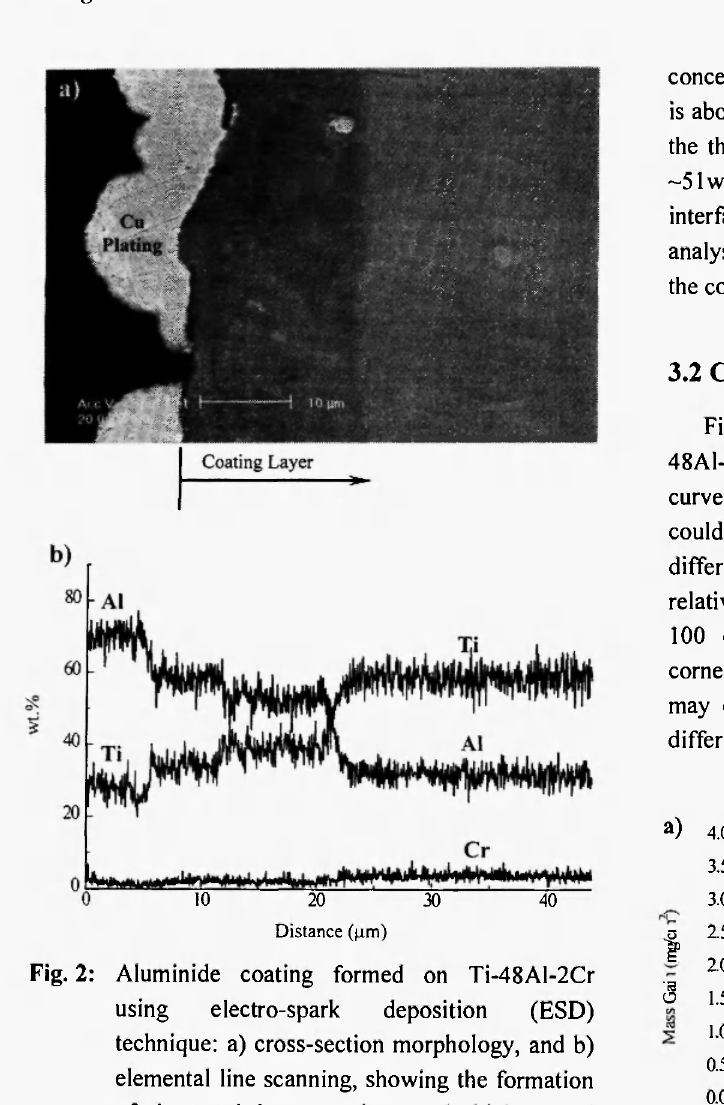
20 Distance (μηι) Fig. 2: Aluminide coating formed on Ti-48Al-2Cr using electro-spark deposition (ESD) technique: a) cross-section morphology, and b) elemental line scanning, showing the formation of three sub-layers and a total thickness of about 20μηι.